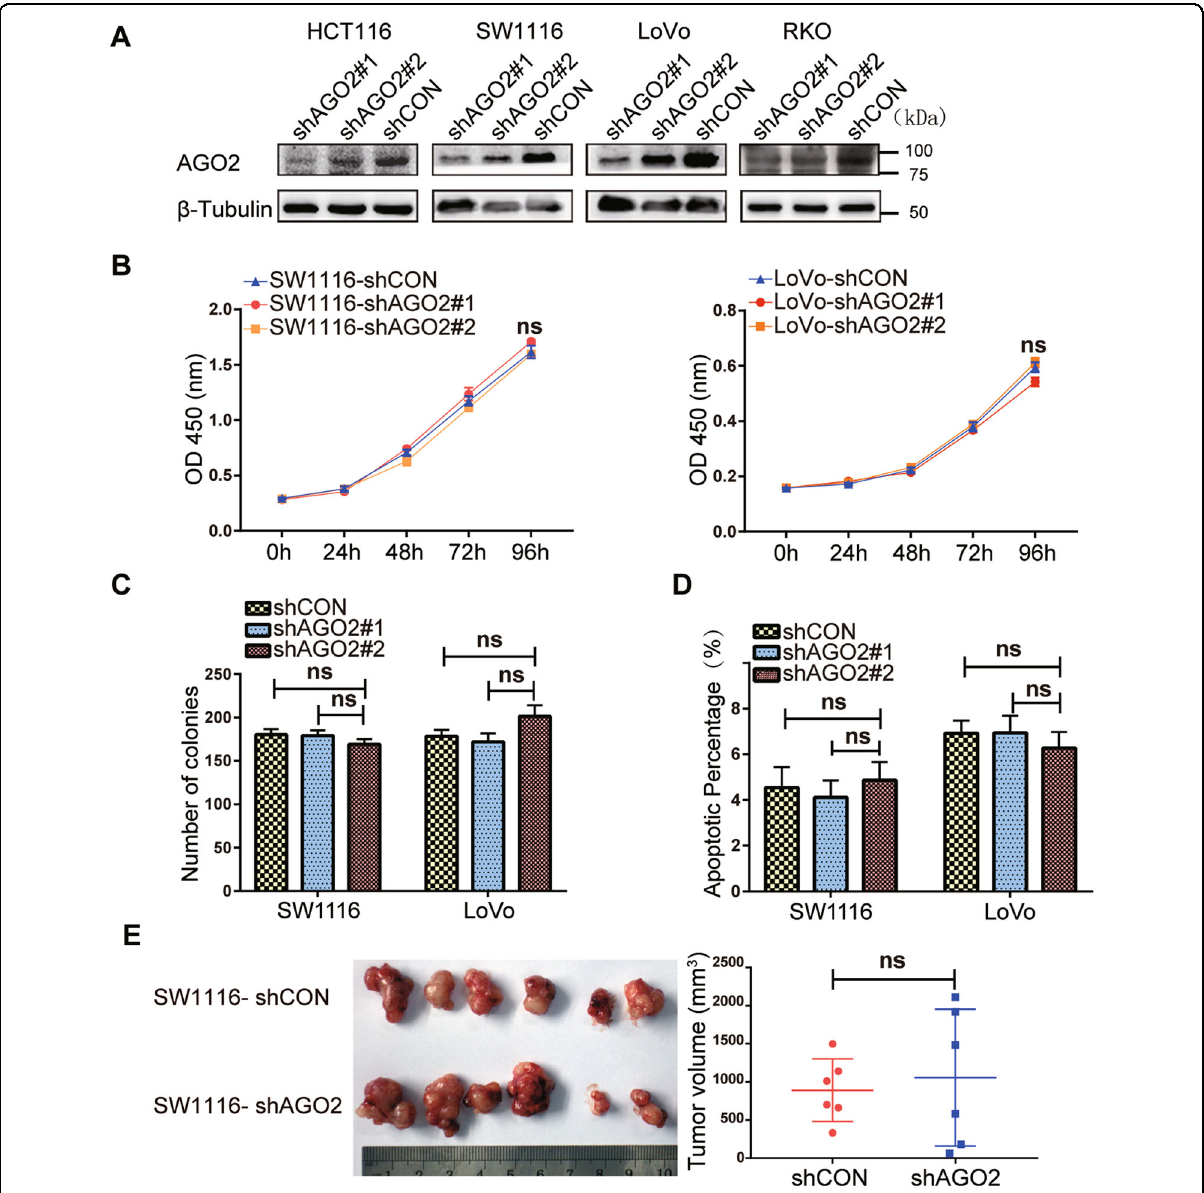
Fig. 2 AGO2 knockdown has no in fl uence on the growth of CRC cells. A Representative immunoblots for AGO2 expression in CRC cell lines stably transfected with shAGO2 or shCON. B CCK-8 assay in SW1116 (left) and LoVo (right) cells. C Statistical analysis of colony formation assays. D Statistical analysis of early and late apoptotic cells. E Representative photographs (left) and statistical analysis (right) of tumor xenografts in mice (n = 6 per group). Data are expressed as the mean ± SD, ns no signi fi cance, p >